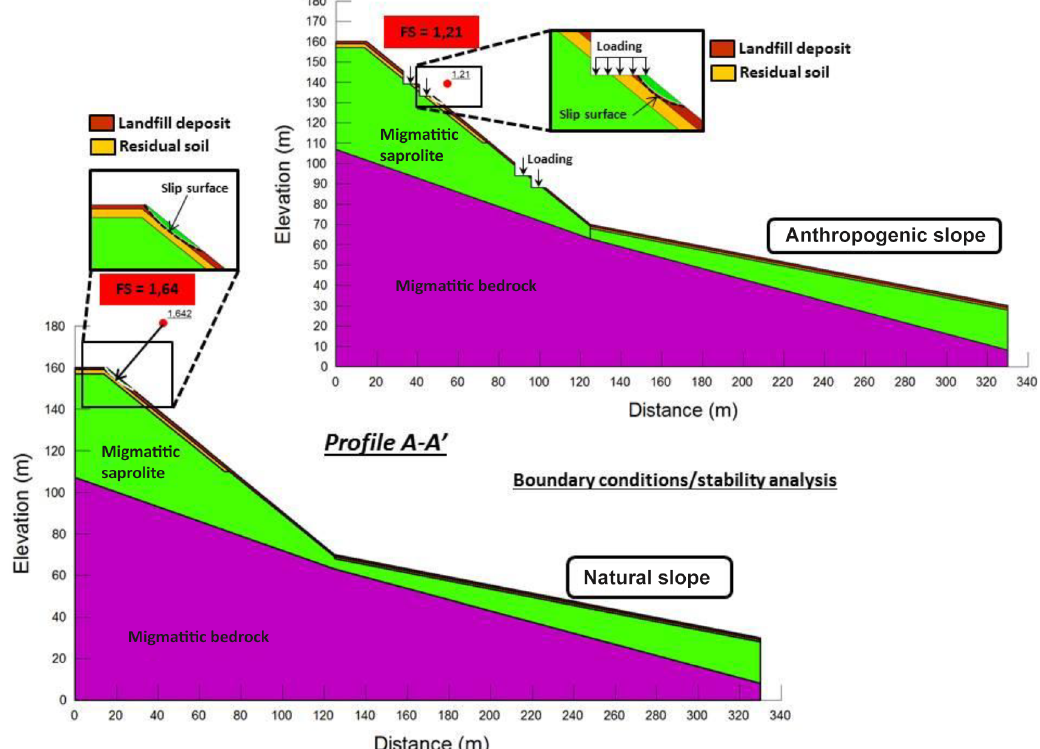
Figure 6. Slope geometry and boundary conditions used in the stability analysis with natural and anthropogenic factors (rainfall, cut slope, loading and